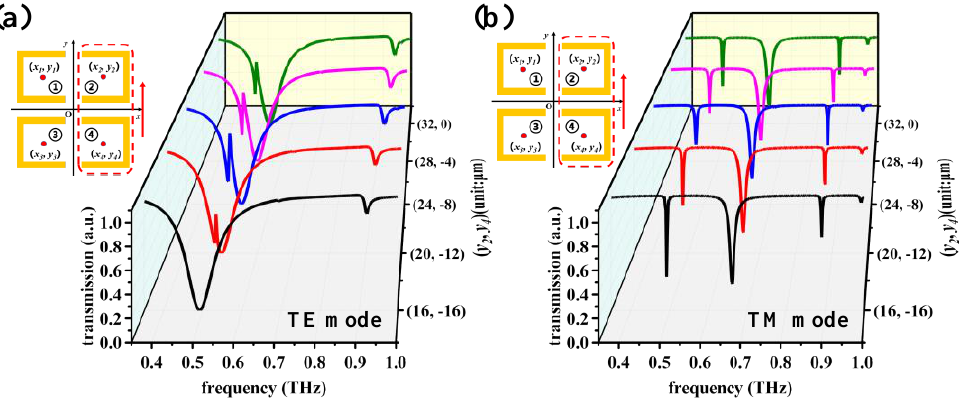
Figure 4. Simulated transmission spectra of the RTM device obtained by moving the SRR-2 and SRR-4 meta-atoms along positive y -axis direction in ( a ) TE and ( b ) TM modes.